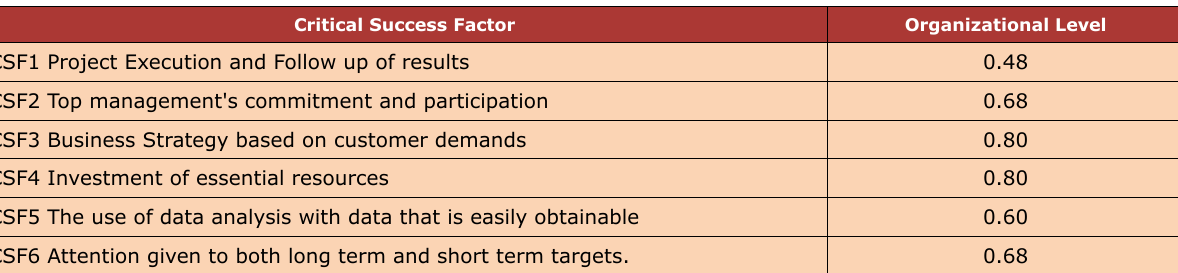
Table 6. Sample CSF level